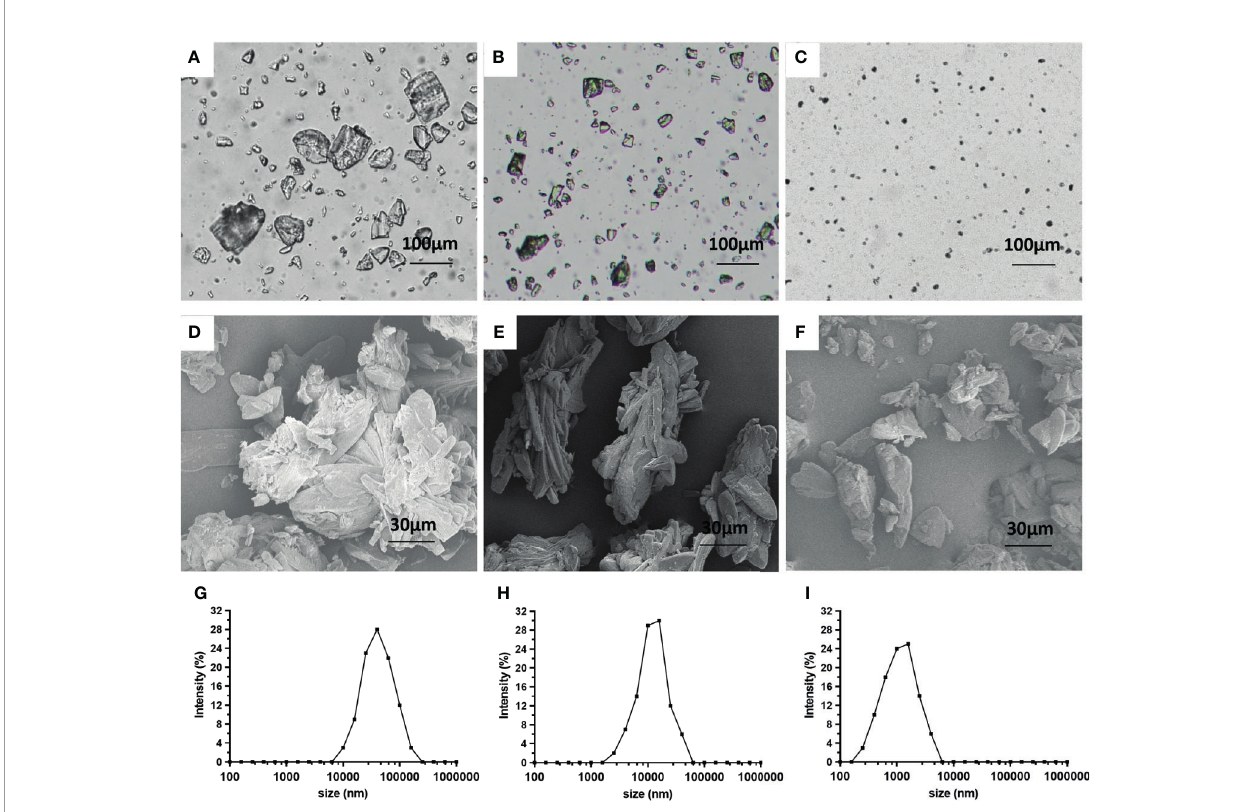
FIGURE 1 | Preparation of sorafenib microcrystal formulations. The microcrystal formulations were observed by an optical microscope (A – C) or a conventional transmission electron microscope (D – F) . Particle size distribution charts of the sorafenib microcrystal formulations (G – I)